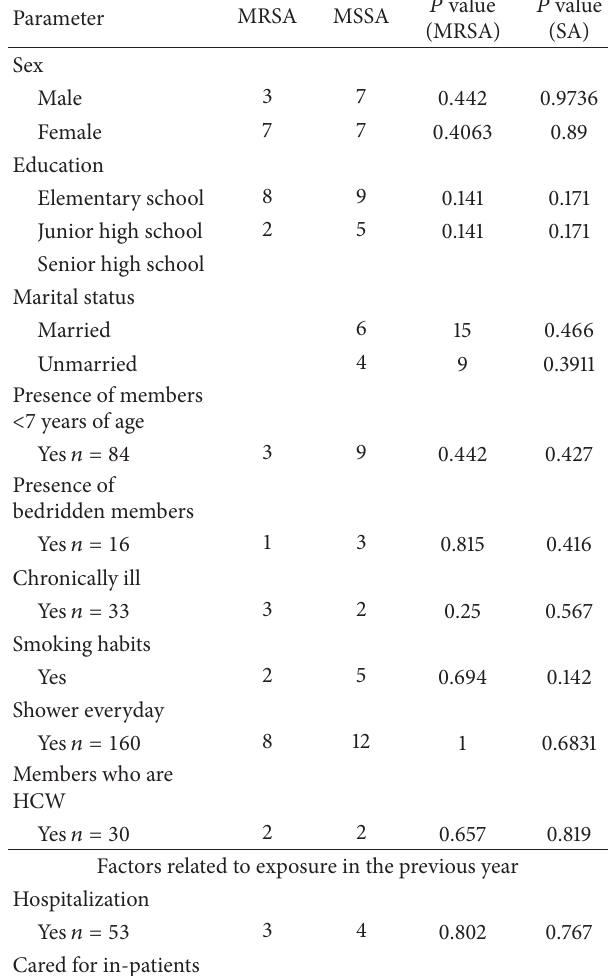
Table 1: Calculated correlation between SA nasal and MRSA nasal colonization and various other surveyed